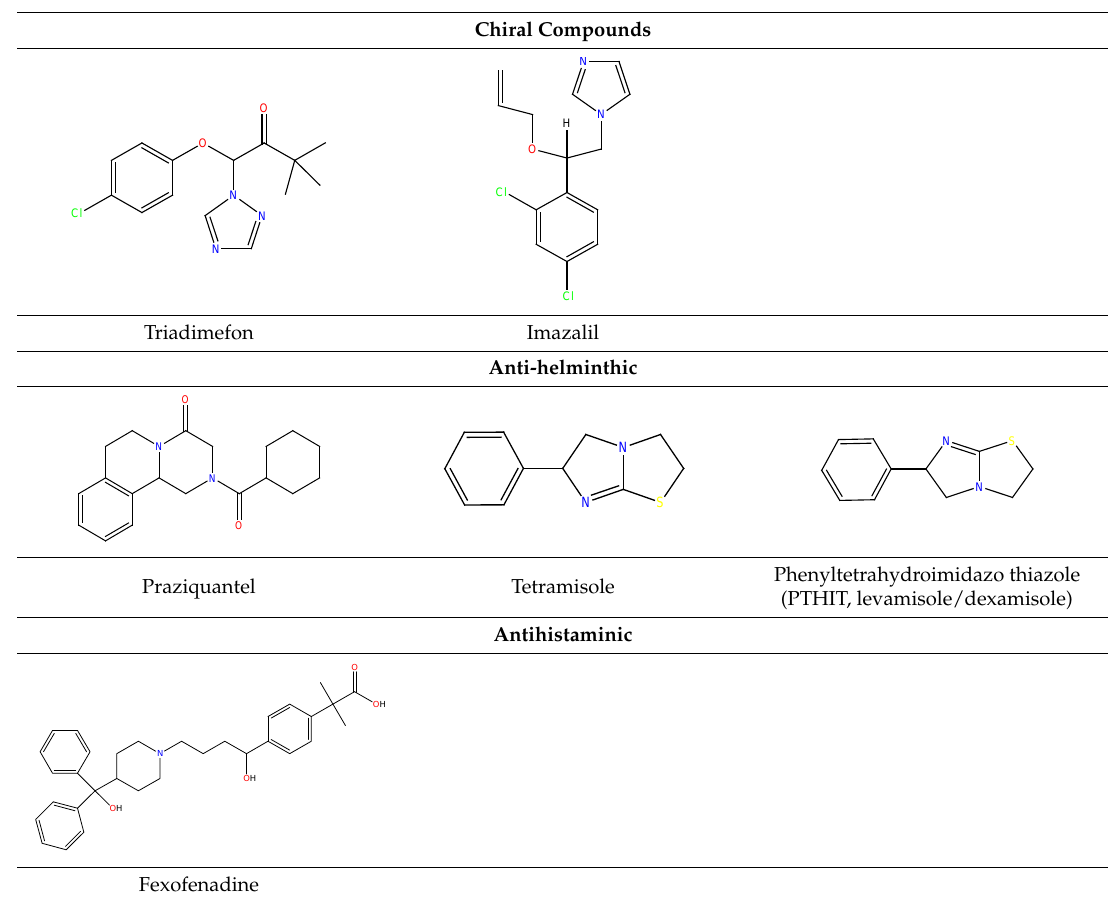
Figure 2. Relative number of each class of chiral drug referred in the reviewed enantioselective published studies and the analytical methods used for separation of the chiral drugs in biological fluids.